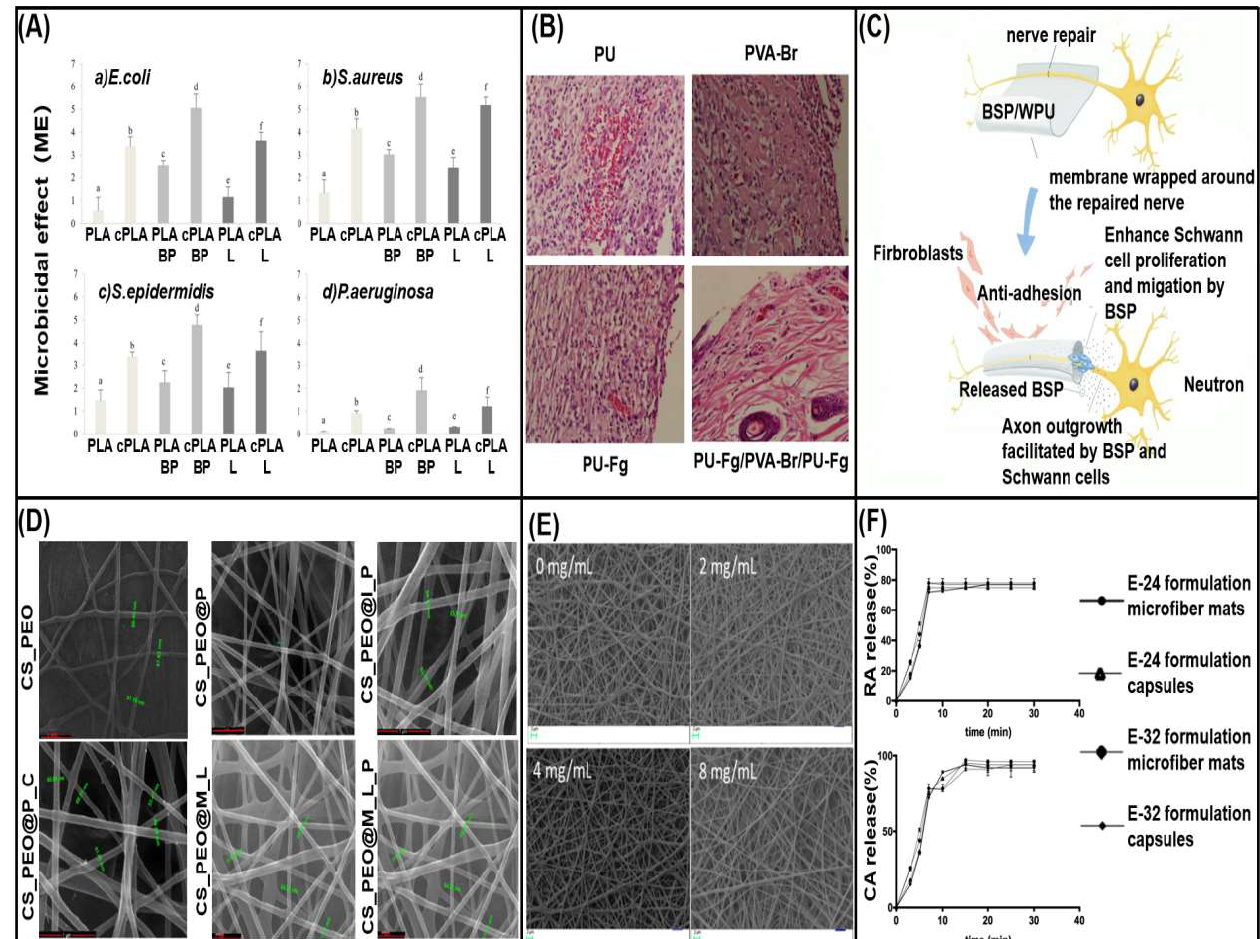
Figure 7. Synthetic polymer-loaded herbal medicine nanofibers. ( A ) Antibacterial activity of fibers against different bacterial strains, reprinted with permission from [49] copyright 2021,